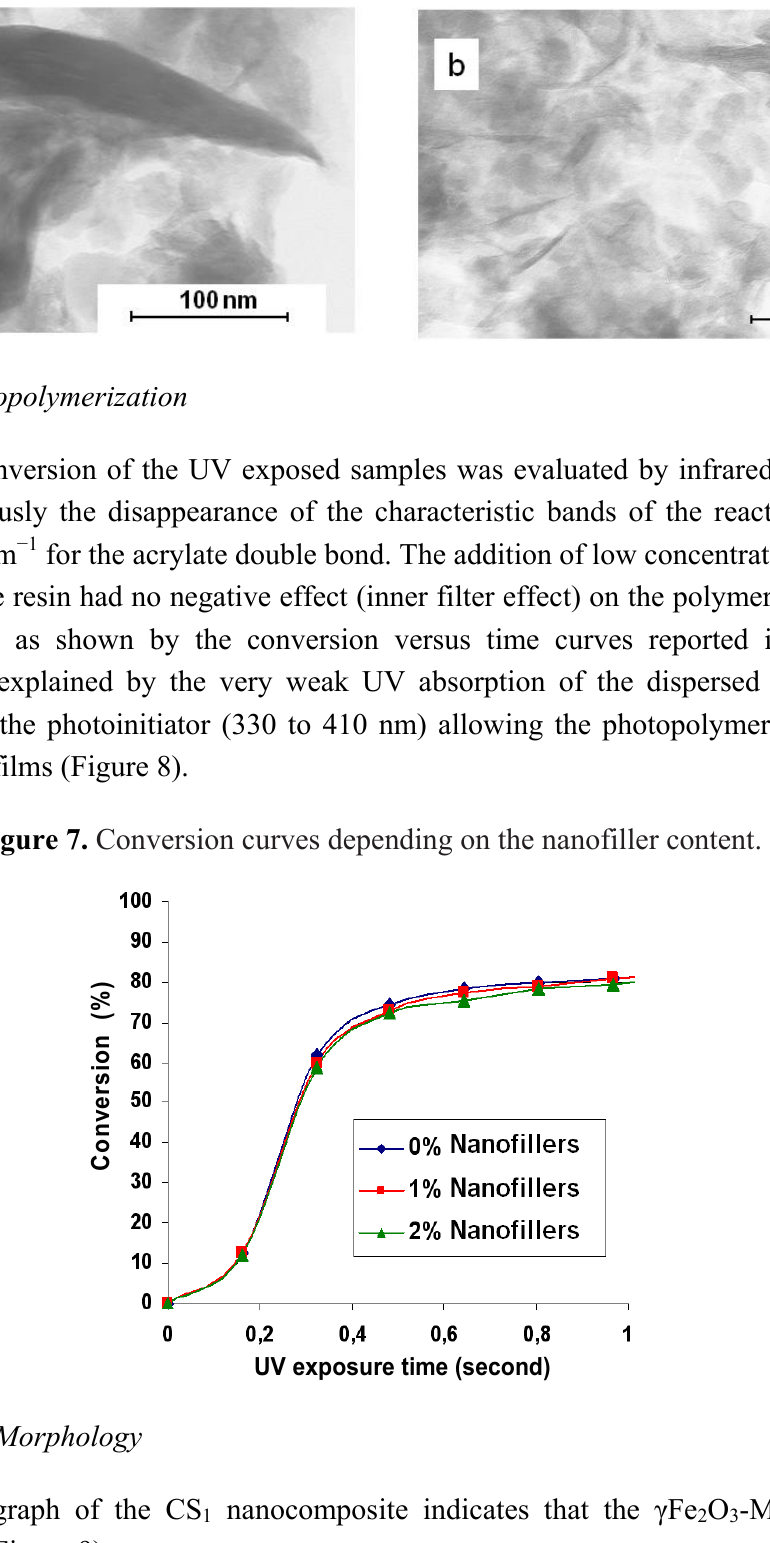
Figure 6. Transmission electron microscopy (TEM) micrographs of ( a ) Na-MMT and ( b ) Mo-Mag